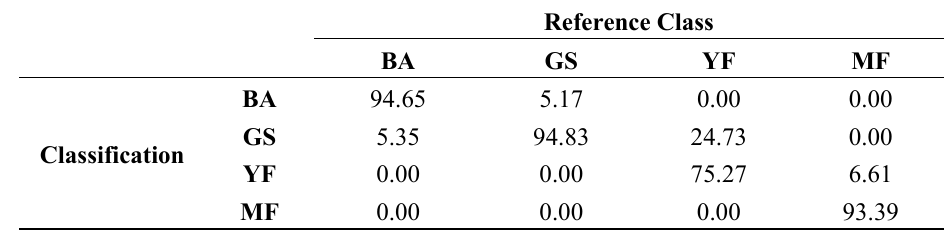
Table 3. Accuracy assessment of Classification 2 (per cent): image segmentation using AVNIR data, classification using AVNIR data, topographic data and grey level co-occurrence matrix (GLCM) texture measures calculated from ALOS PRISM data (overall accuracy: 0.887, Kappa: